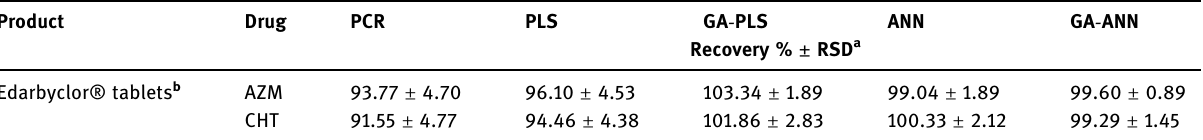
Table 5: Determination of AZM and CHT in Edarbyclor ® tablets ( Batch No. 459512 ) by the proposed chemometric methods Product